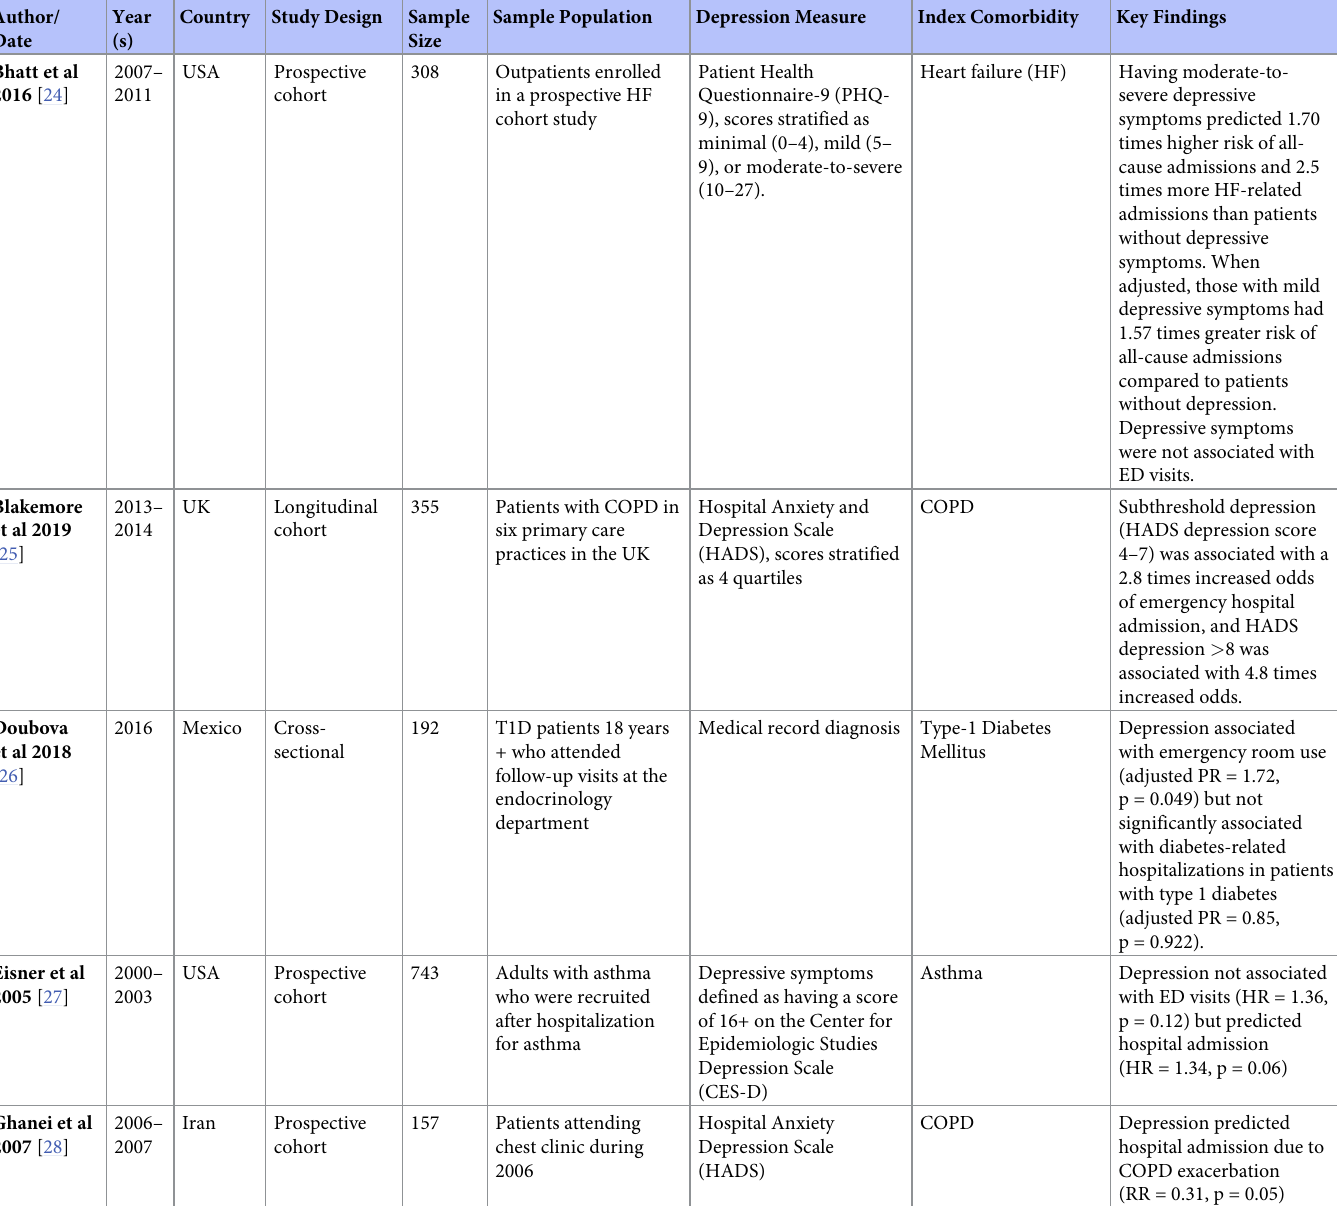
Table 1. Characteristics and findings of studies included in systematic